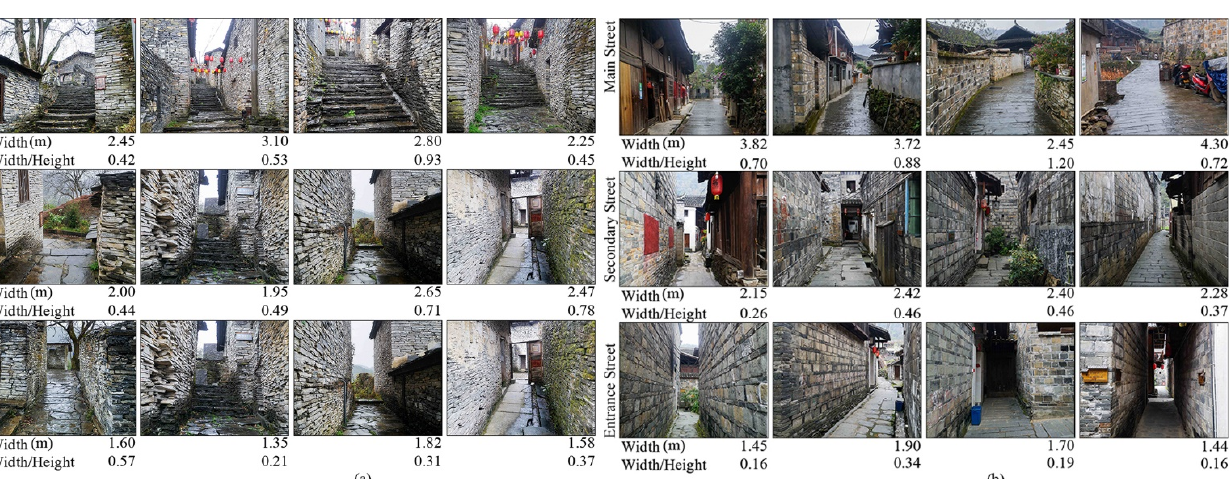
Figure A2. The moisture content of the ancient village houses’ wood. ( a ) High chair Village; ( b ) Pingtan village; and ( c ) Shuangfeng village.